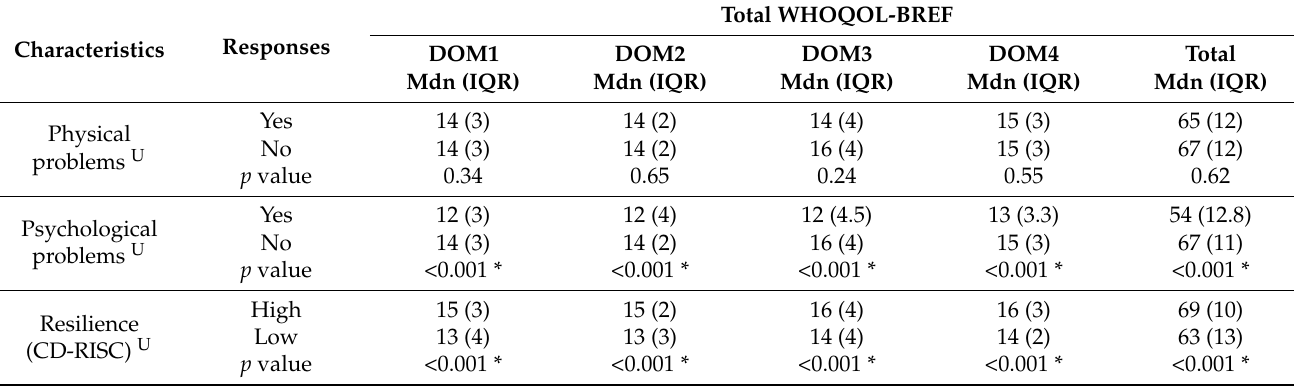
Table 2. A comparison of the WHOQOL-BREF Scores according to the physical, psychological problems and resilience of the respondents and their level of